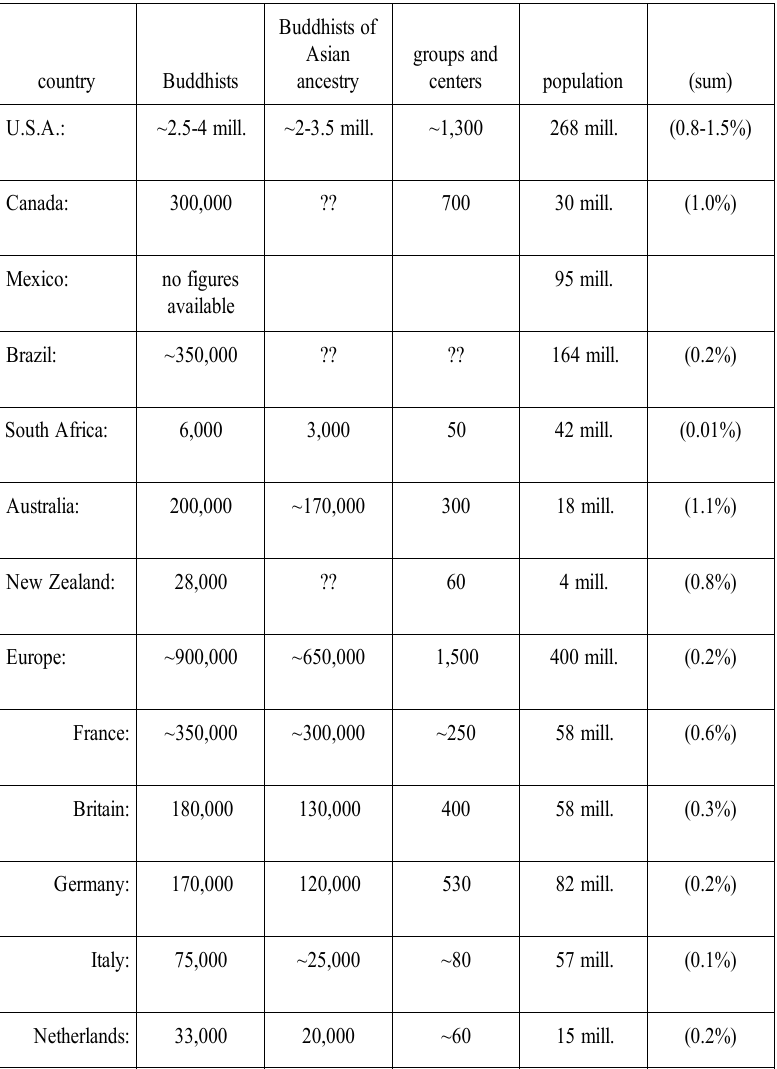
Table 1: Buddhists and Buddhist groups in selected countries outside of Asia; estimates for the late 1990s yrtnuoc stsihdduB